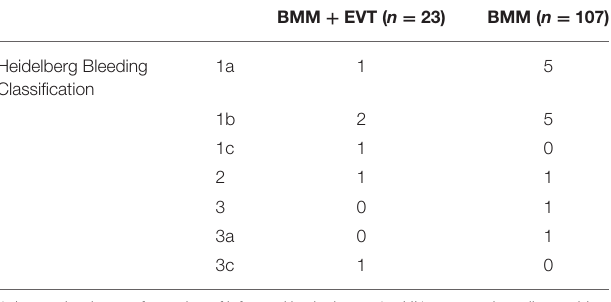
TABLE 2 | Procedural and outcome parameters. TABLE 3 | ICH distribution according to the Heidelberg Bleeding